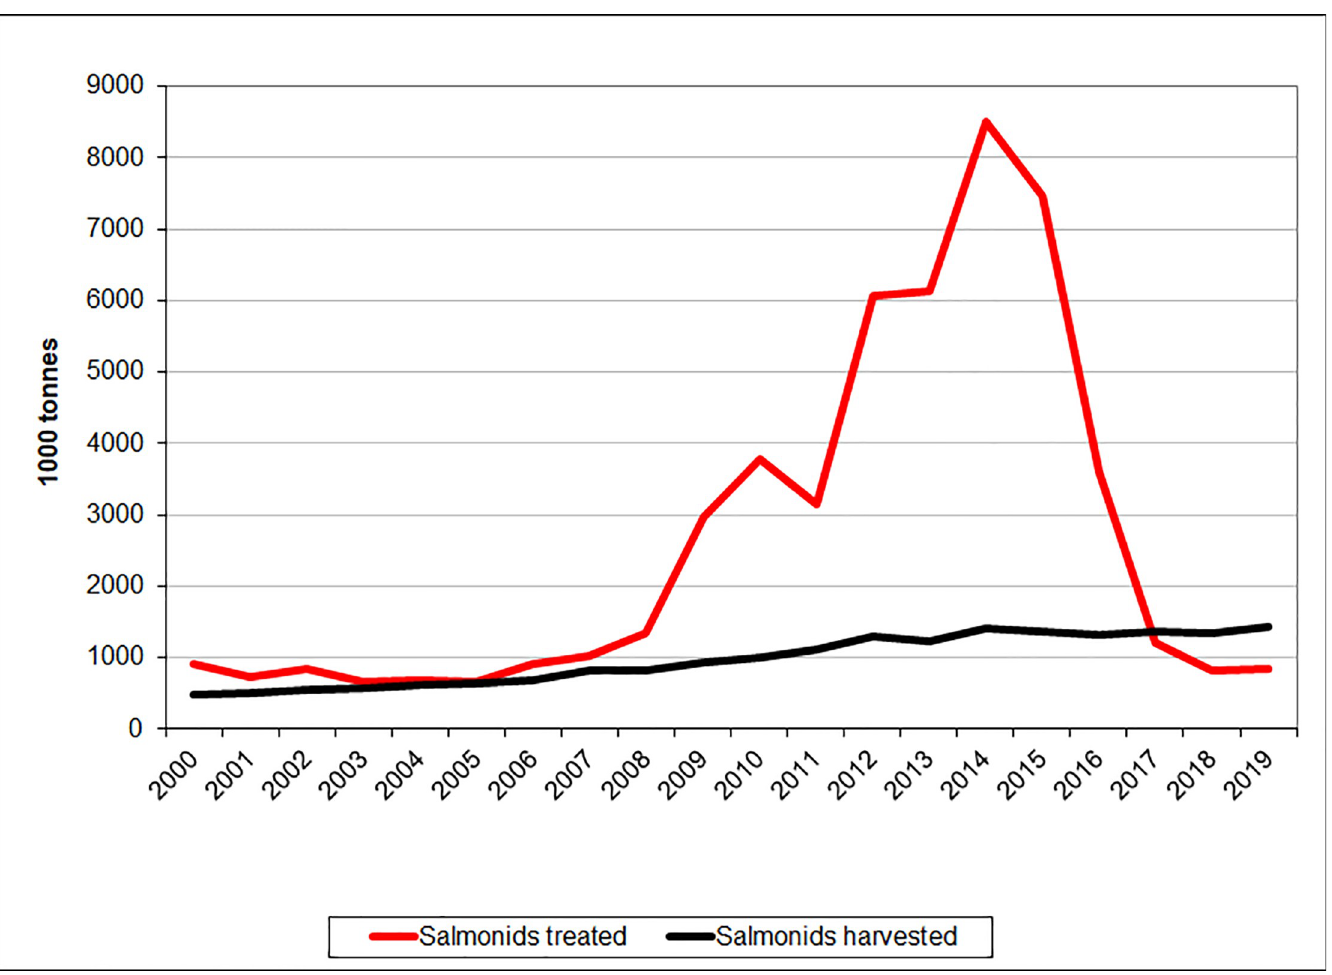
Fig 1. Treated versus harvested salmonid